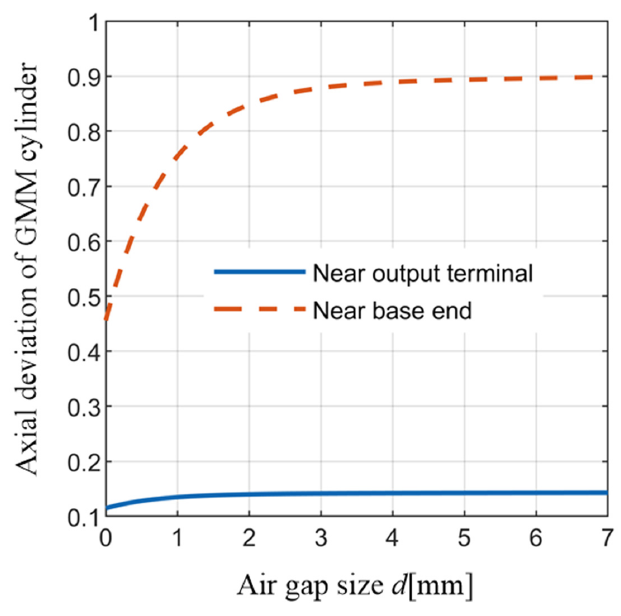
Figure 18. Influence of air gap size on deviation of axial magnetic density of GMM cylinder.